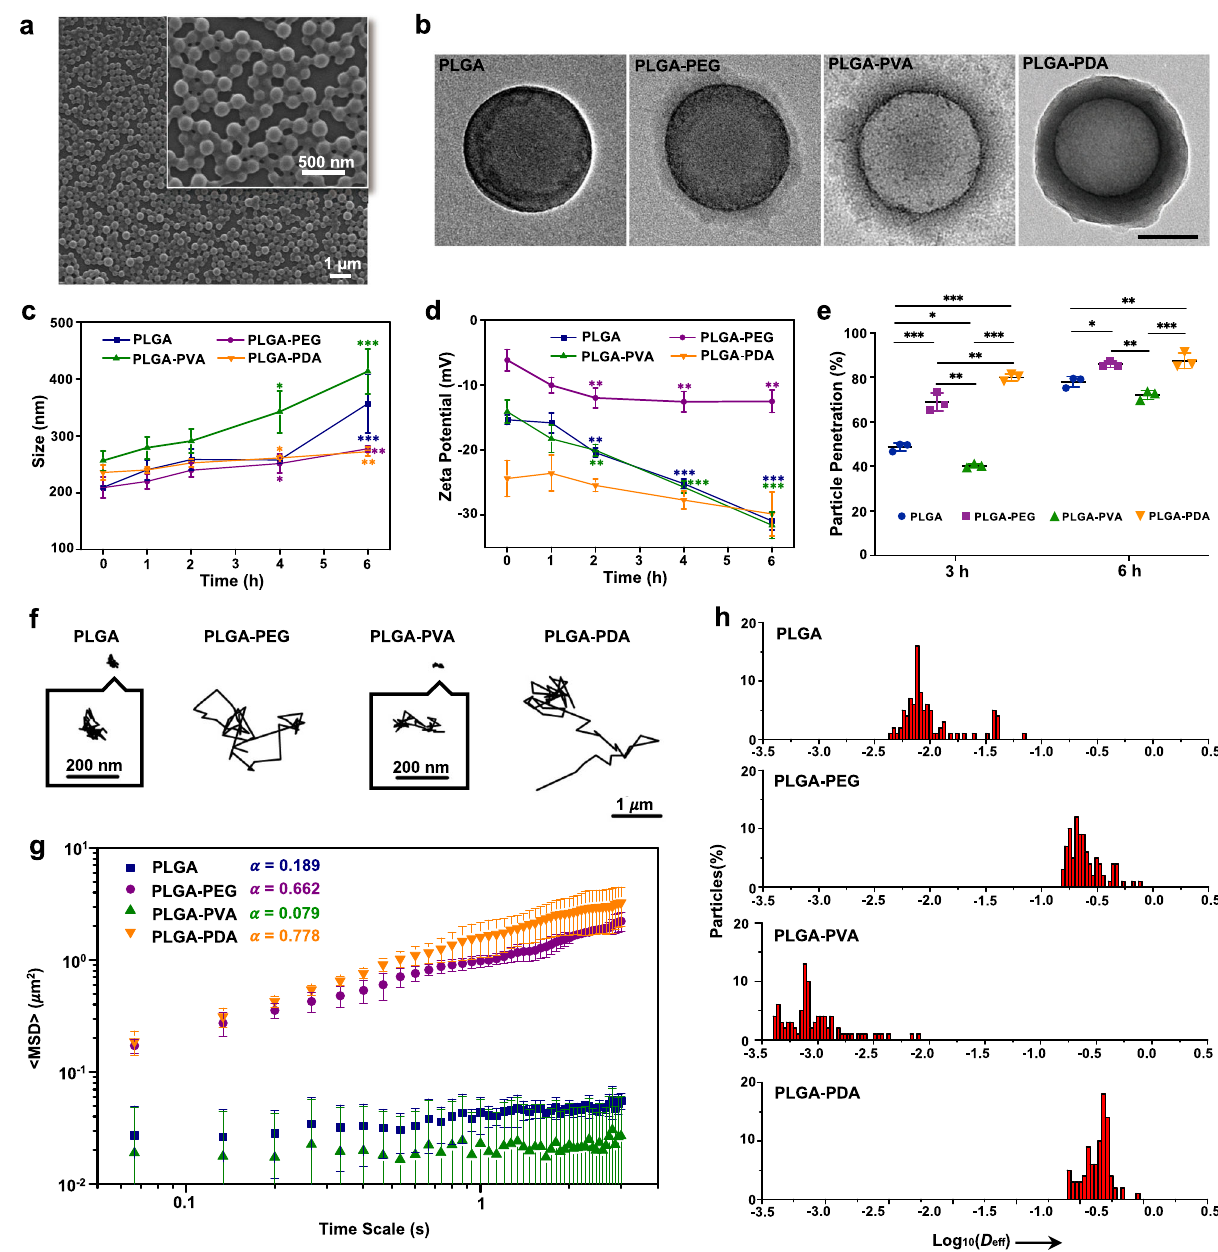
Fig. 4 Characterization and mucus-penetrating properties of NPs in vitro. a SEM image of PLGA NPs. b TEM images of PLGA, PLGA-PEG, PLGA-PVA, and PLGA-PDA NPs. PLGA: poly(lactic-co-glycolic acid), PEG: poly(ethylene glycol), PVA: poly(vinyl alcohol), PDA: polydopamine. Scale bar: 100 nm. c Variation in the particle size of different NPs-Mucin mixtures as a function of time. * P < 0.05; ** P < 0.01; *** P < 0.001 vs value at 0 h. d Variation in the zeta potential of different NPs-Mucin mixtures as a function of time. ** P < 0.01; *** P < 0.001 vs value at 0 h. e Percentage of N P s that penetrated across the mucus lay e r in a Transwell assay after 3 h and 6 h. * P < 0.05; ** P < 0.01; *** P < 0.001. f Representative trajectories of different NPs in mucus. g MSD (mean squared displacement) values as a function of time scale for different NPs in mucus. h Distributions of the logarithms of individual particle effective diffusivities (D eff ) values at a time scale of 1 s. All data are Mean± S.D. n = 3 independent samples per group. Statistics was calculated by one-way ANOVA followed by Tukey ’ s post-test. Exact P values are given in the Source Data fi le. Source data are provided as a Source data fi